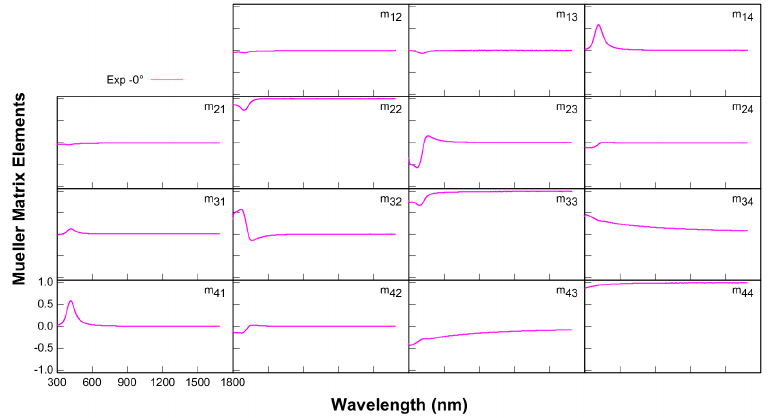
Figure A2. Mueller matrix measured in transmission mode at normal incidence. Data below wave ‐ length 300 nm are omitted because of the strong absorption of the glass substrate.